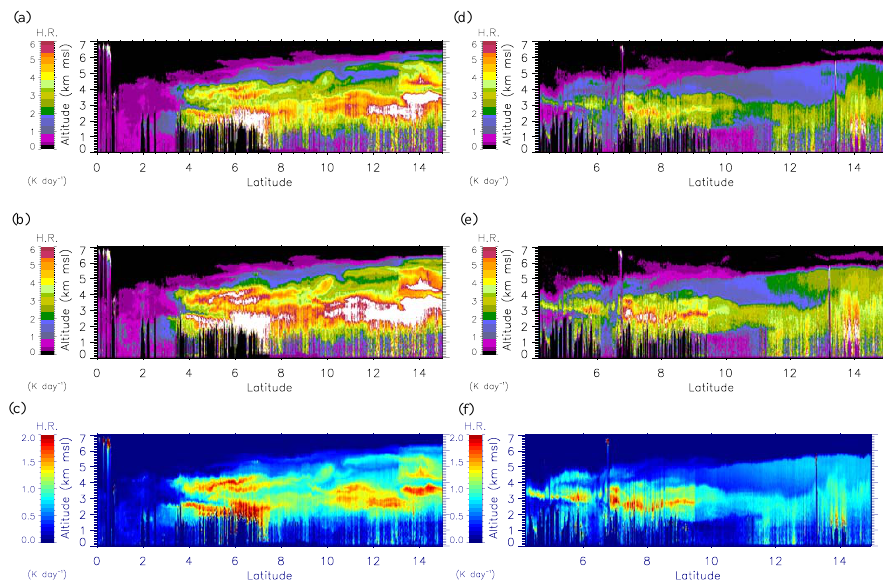
Fig. 11. Heating rate transect derived from LEANDRE 2 aerosol extinction coefficient profiles on 13 June 2006 using the RaCH model (a) and the CHOM model (b) . (c) The difference between the two heating rate fields shown in (a) and (b). (d) , (e) and (f) are as in (a), (b) and (c) but on 14 June 2006.